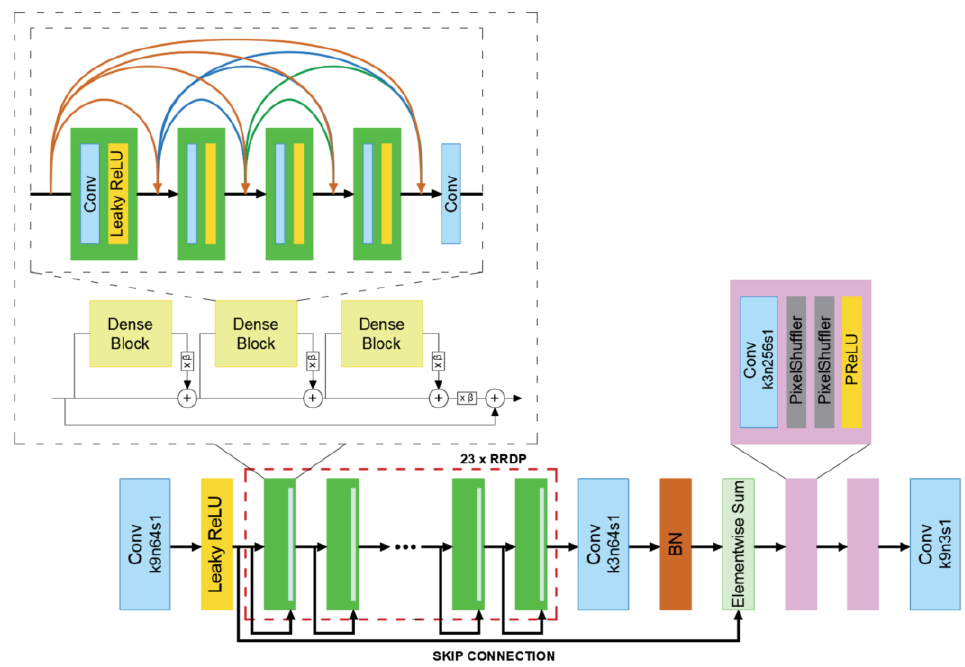
Figure 7. Model of the ESRGAN network generator (base on [41]).